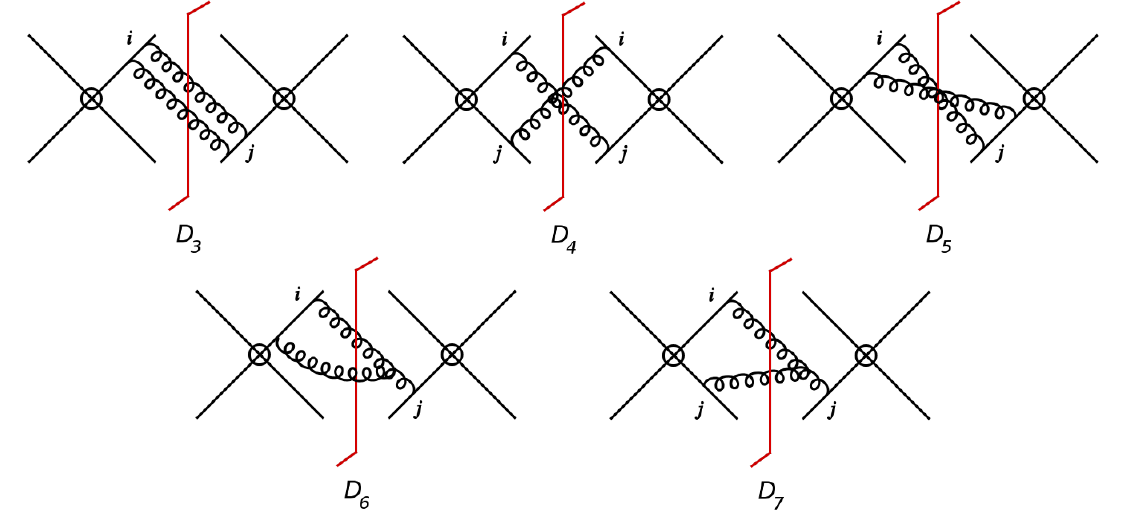
Figure 5 . Two-Wilson-line, double-cut diagrams required for the calculation of the NNLO soft